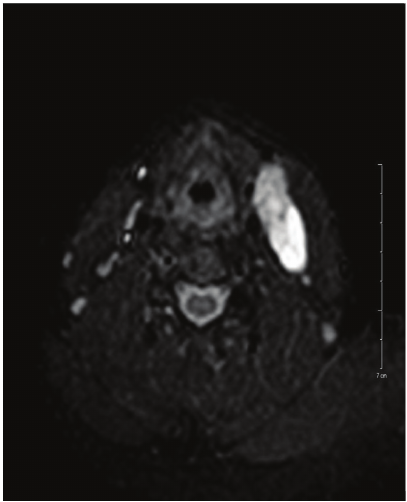
Figure 1: Contrast enhanced, axial sliced MR imaging of the cystic lesion.